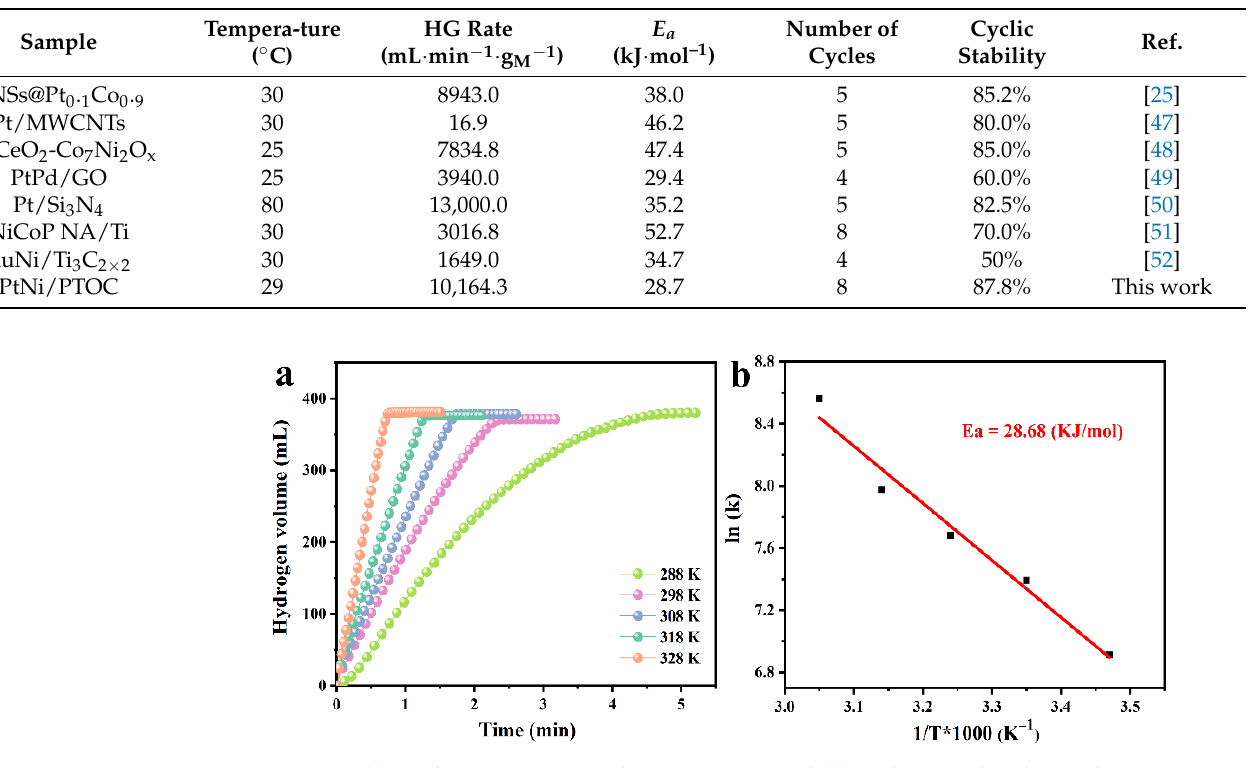
Figure 8. ( a ) Hydrogen generation kinetics curves and ( b ) Arrhenius plot obtained using 1.5 wt% NaBH 4 and 1.0 wt% NaOH solution and employing PtNi/PTOC as a catalyst at different solution